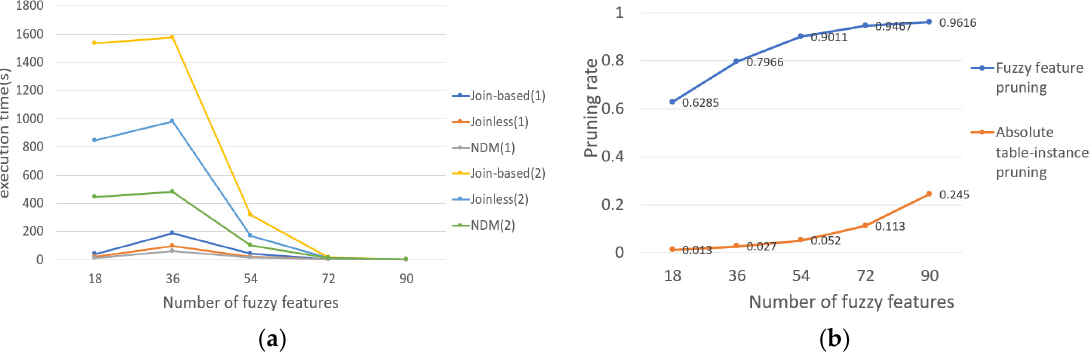
Figure 14. ( a ) Effect of the number of attributes; ( b ) Pruning degree of the two